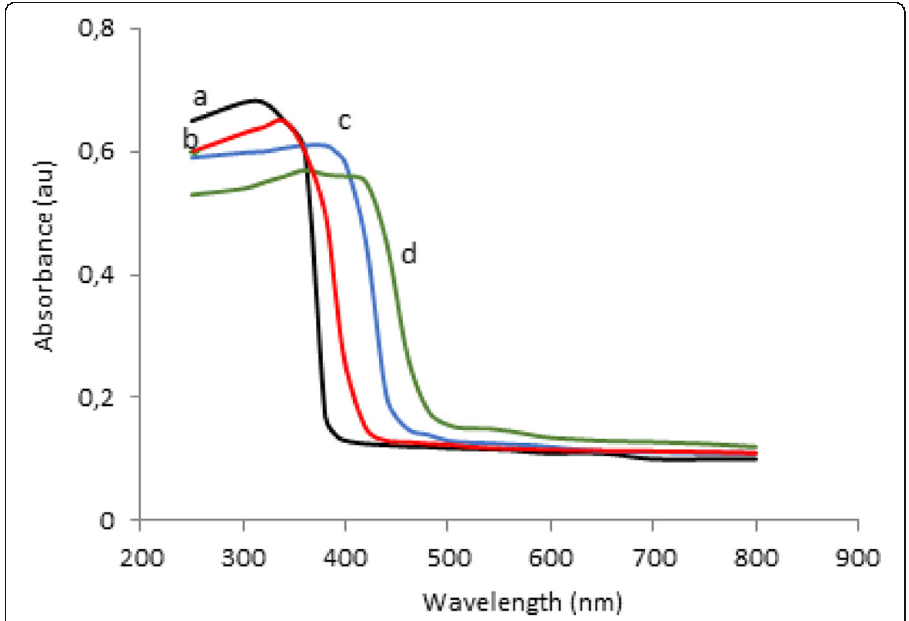
Fig. 1 The SRUV Spectra of a TiO 2 , b TiO 2 -N,S(1:1:0.5), c TiO 2 -N,S(1:1:1), and d TiO 2 -N,S(1:1:1.5)